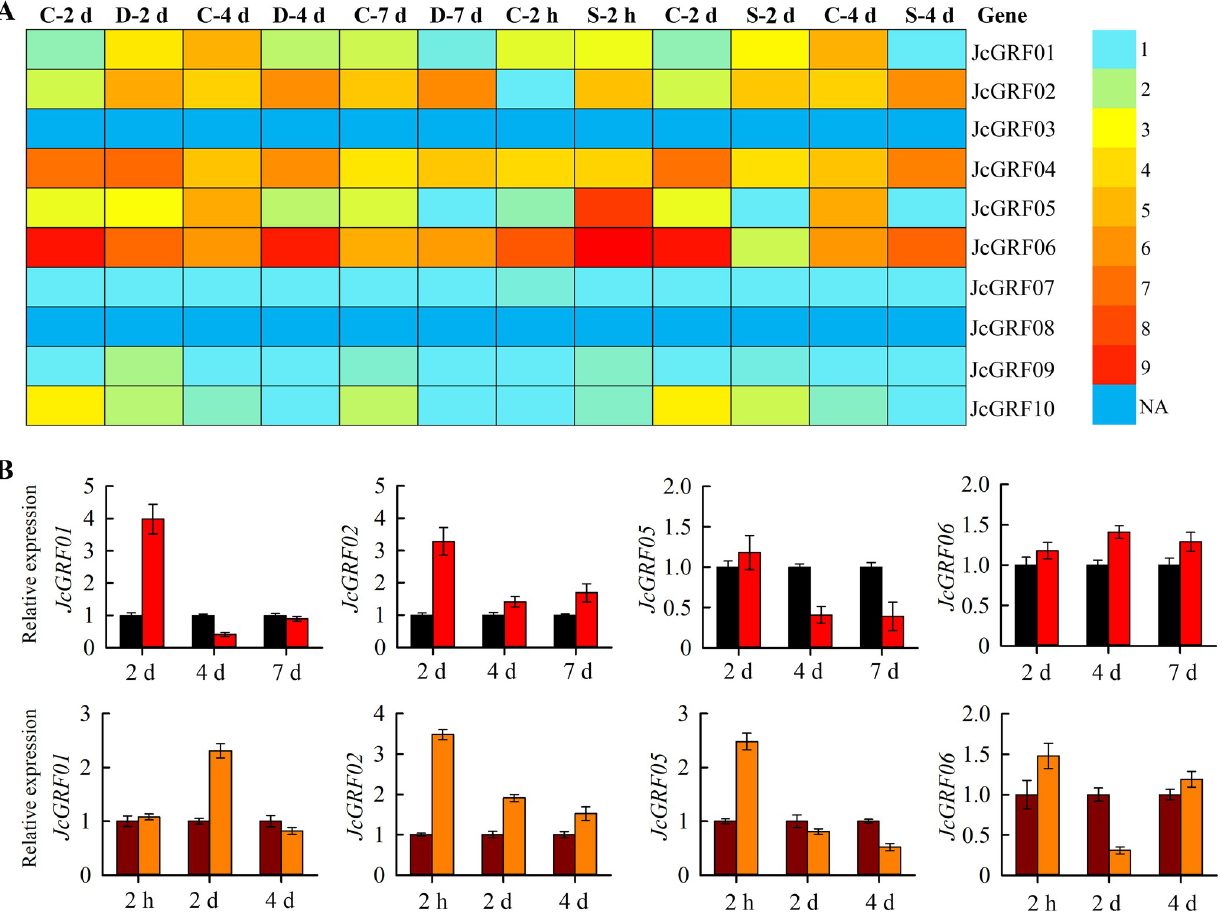
Fig 7. Transcription abundance of JcGRF genes in Jatropha curcas roots under drought and salinity stress. (A) The transcription level of JcGRF genes exposed to drought and salt stress, with a colored scale of expression levels shown on the right. NA (not available), C (Control), D (Drought), S (Salinity). (B) Relative expression levels of JcGRF genes in Jatropha curcas roots by qRT-PCR under drought (2 d, 4 d and 7 d) and salinity (2 h, 2 d and 4 d) stresses, and non-stressed treatment as control. Values represent means of n = 3 ± SD from three biological repeats.